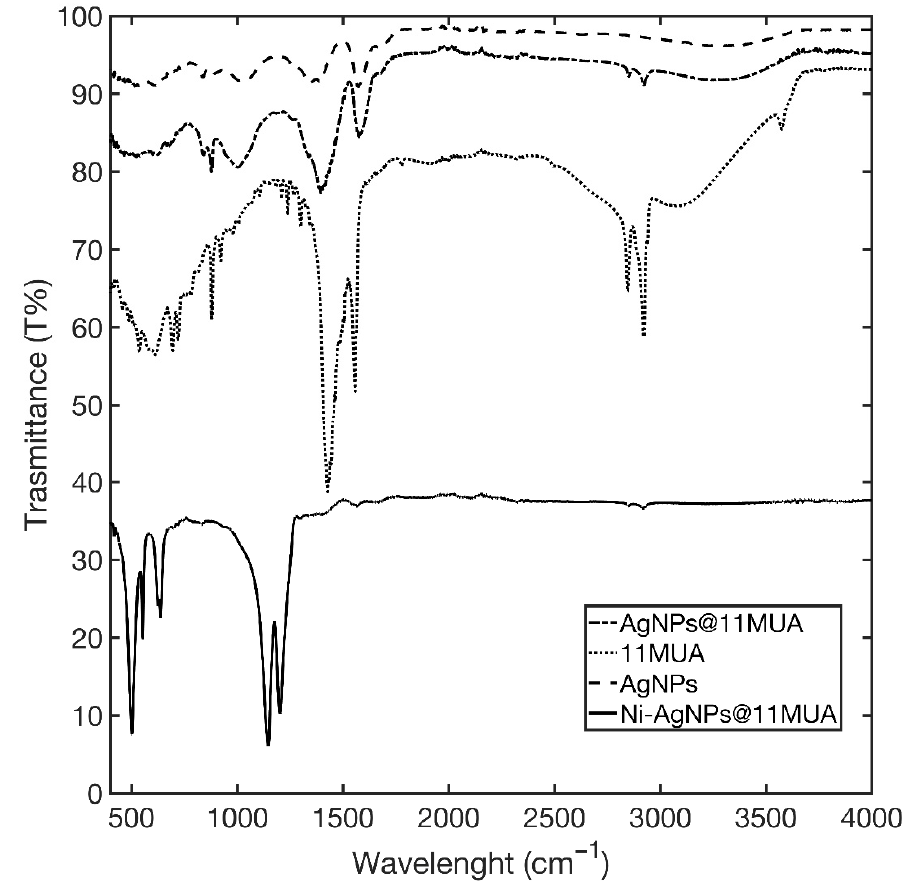
Figure 4. IR spectra of the AgNPs@11MUA (solid line), 11MUA (line dash point), and AgNPs (dashed line).